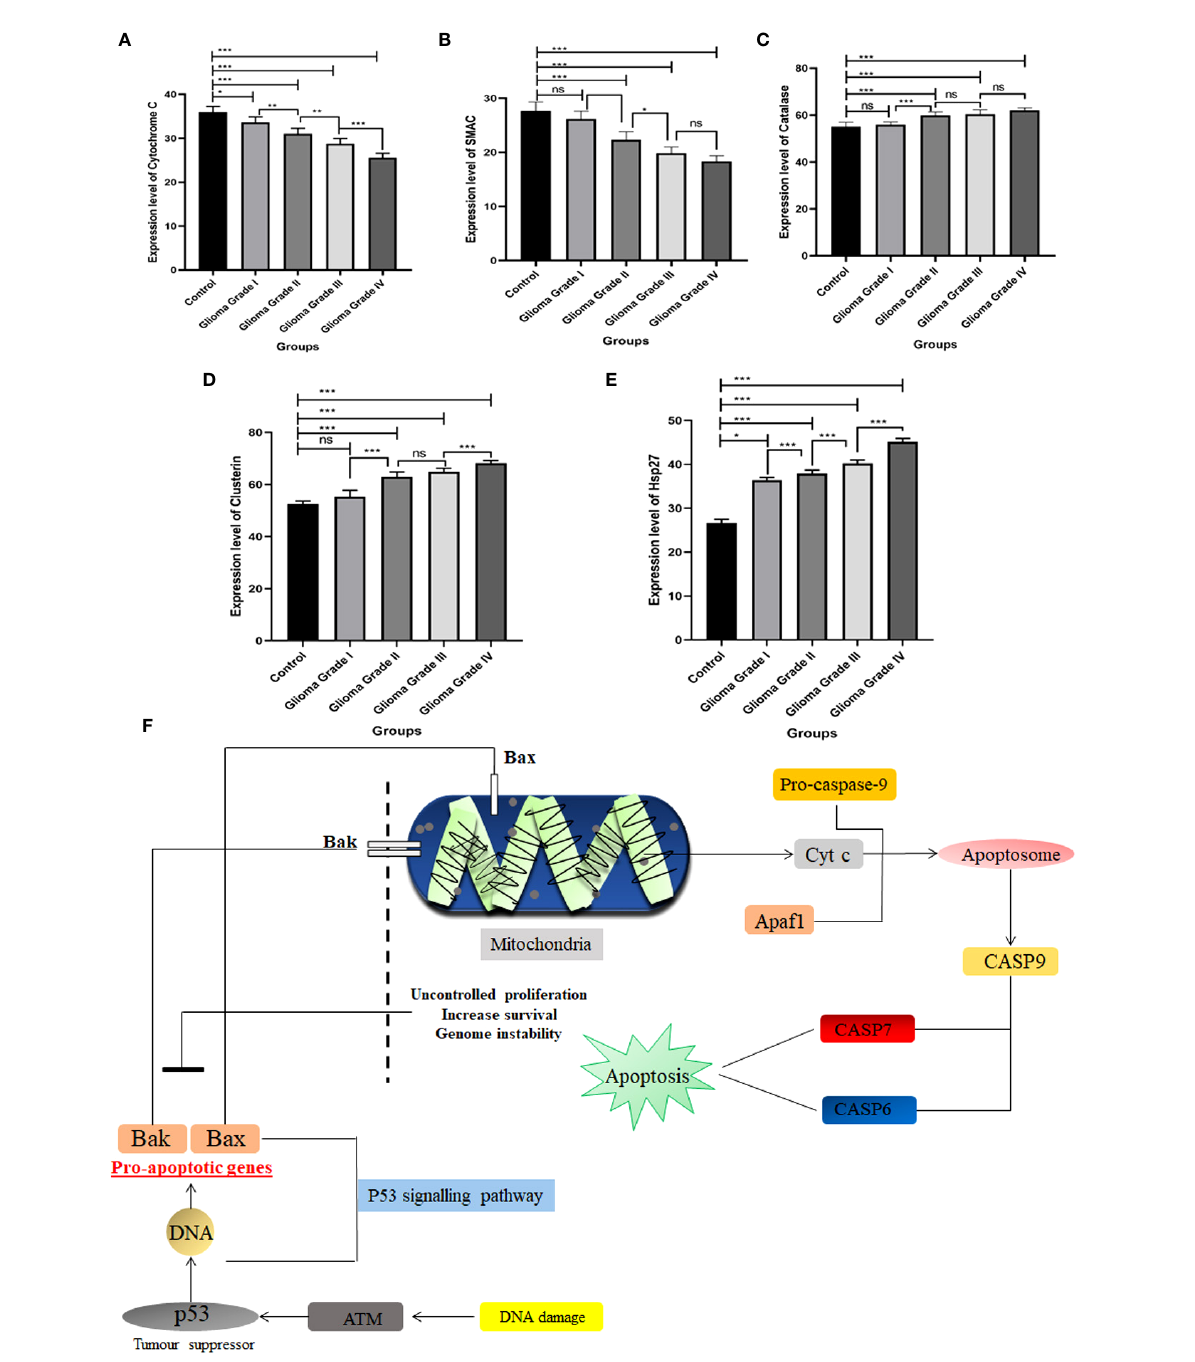
FIGURE 3 Expression pattern of different apoptosis proteins identi fi ed in Human Apoptosis Array. Total protein samples isolated from different grades of gliomas along with normal brain tissue were analyzed using a human apoptosis array kit. (A) Expression level of Cytochrome C gets down- regulated among different grades of Glioma with compared to control. (B) SMAC expression level gets down-regulated in different grades of Glioma in contrast to control. (C) Catalase expression increases in different grades of Glioma. (D) Expression of Clusterin protein among the different grades with contrast to control. (E) Hsp27 expression pattern in different grades of Glioma with compared to control. (F) Schematic representation of Cyto C pathway in apoptosis w.r.t Glioma. Cyto C activates apoptosis through the caspase pathway. n =6 per group. A value of *p < 0.05, **p < 0.01, ***p < 0.001, ns not-signi fi cant (p >